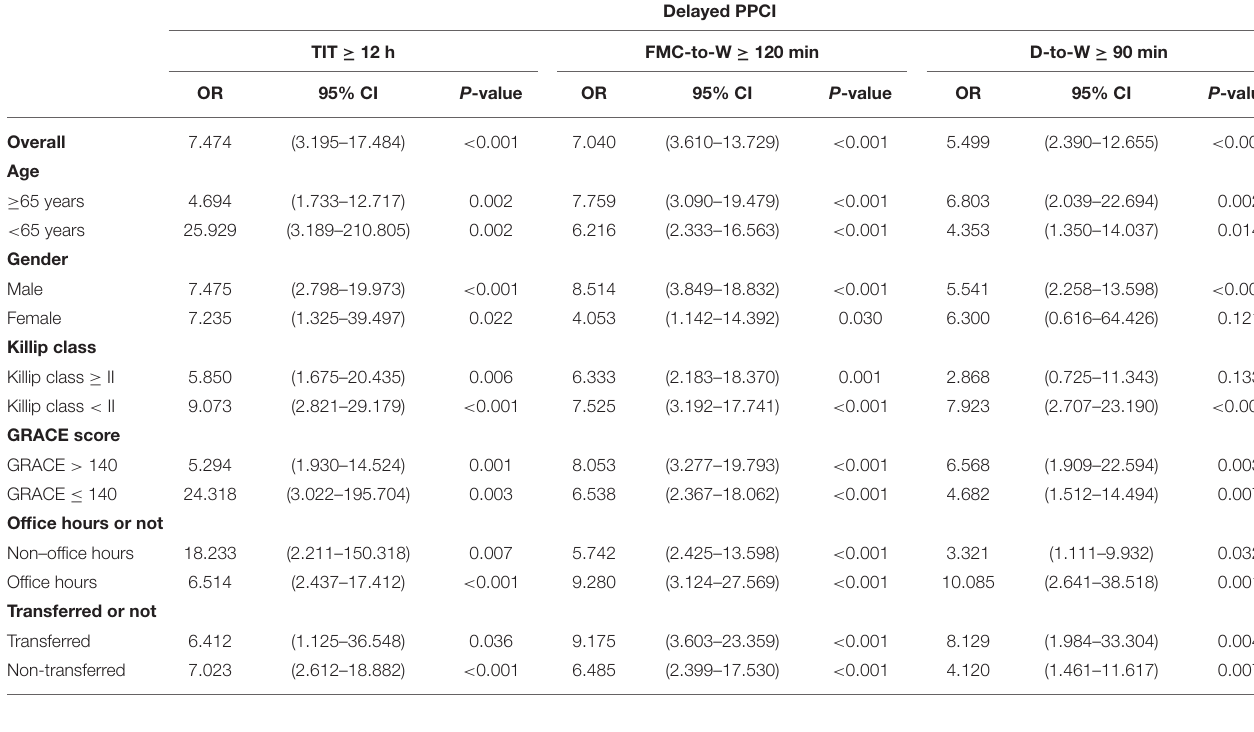
TABLE 5 | Logistic analyses for the association of COVID-19 pandemic with delayed PPCI.